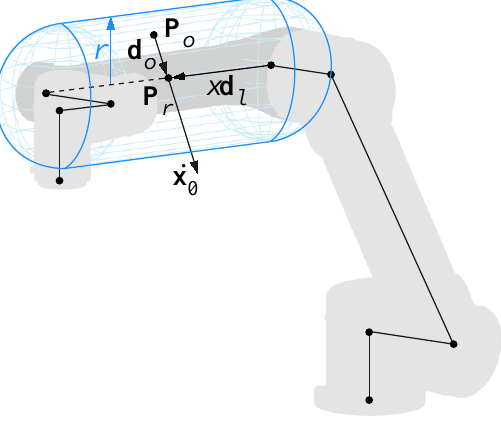
Figure 3. Region of influence of a link and repulsive velocity.